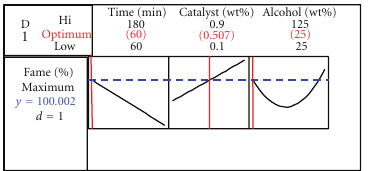
Figure 3: The response optimizer graph showing the optimum